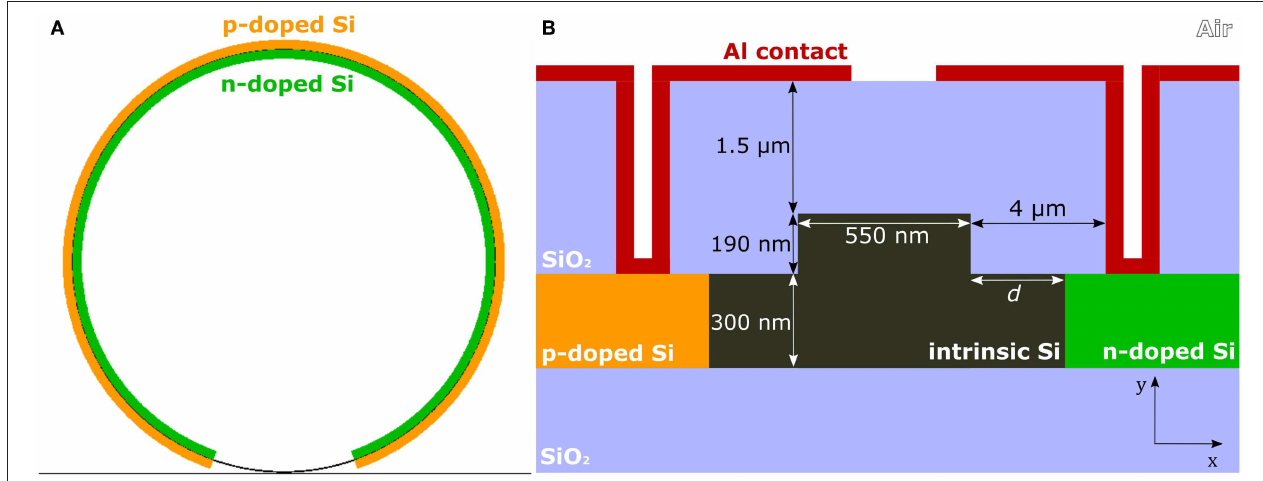
FIGURE 1 | Top-view (A) and cross-section (B) of the resonators described in this